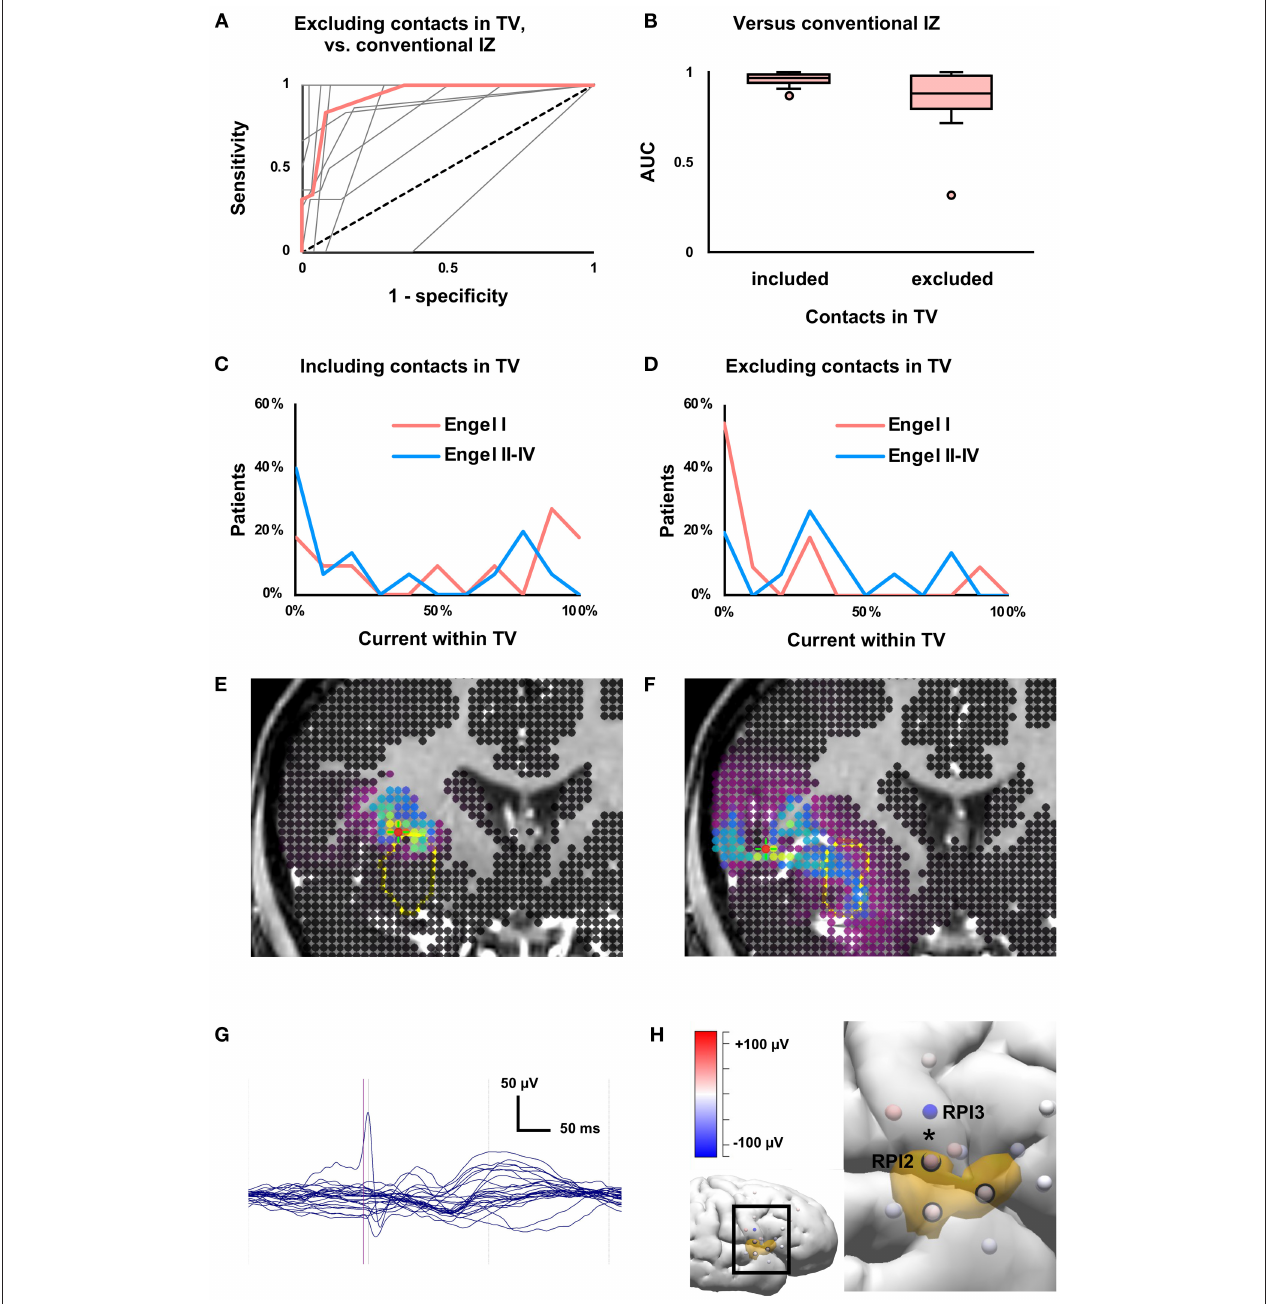
FIGURE 5 | Effects of excluding near-field data from contacts within treatment volume (TV). (A) Receiver-operating characteristic (ROC) curve for concordance of the conventional and modeled irritative zones (IZ) when contacts within the TV were excluded from analysis. Median (thick red line) and individual patient curves (thin gray lines) are shown. (B) Boxplot of ROC area under the curve (AUC), which was not significantly affected ( P = 0.05) by exclusion of contacts within the TV. (C) The proportion of current within the treatment volume (TV) predicted seizure outcome (as in Figure 2A ), but (D) not when within-TV contacts were excluded ( P = 0.22). (E) Current density map (as in Figure 3 ) derived from all depth electrode contacts, from patient with Engel I outcome after laser ablation of insula. In this case, the modeled IZ is located along the border of the TV. (F) Exclusion of contacts within the TV resulted in smearing of current density. (G) Butterfly plot of averaged interictal epileptiform discharges on SEEG from the same patient, showing few channels with high-amplitude discharges. (H) Three-dimensional depiction of relationship between depth electrode contacts (spheres) and TV (orange volume). Inset shows the brain region of interest. Contacts within the TV are circled in black. Contacts are colored according to voltage at the half-rise point. Removing contacts within the TV led to the loss of a high-amplitude phase reversal (*) between adjacent insular contacts RPI2 and RPI3.